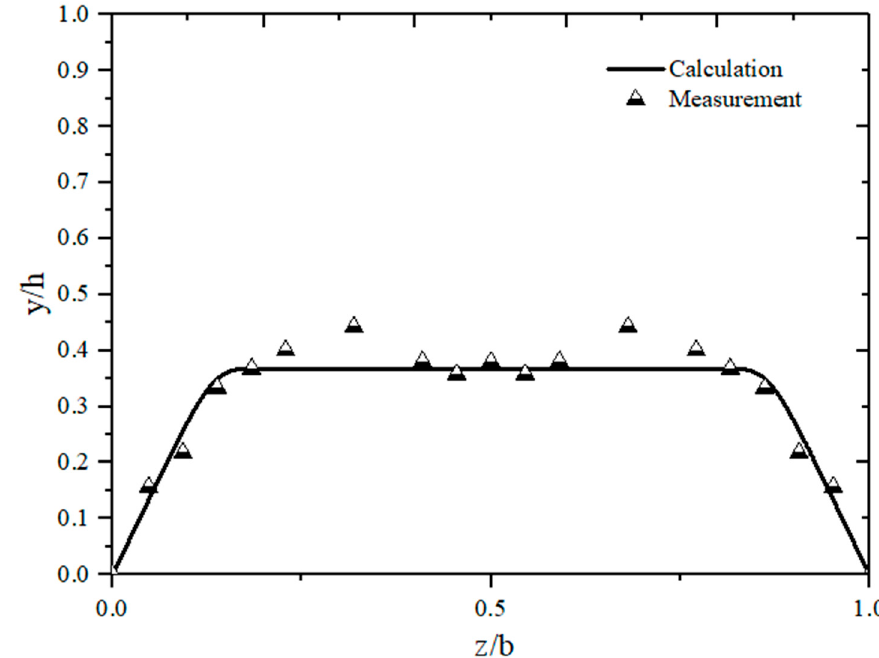
Figure 9. Comparison of the location of depth average velocity between the calculated and measured values along di ff erent vertical lines from the bedform to the water surface ( b / h = 2.727).